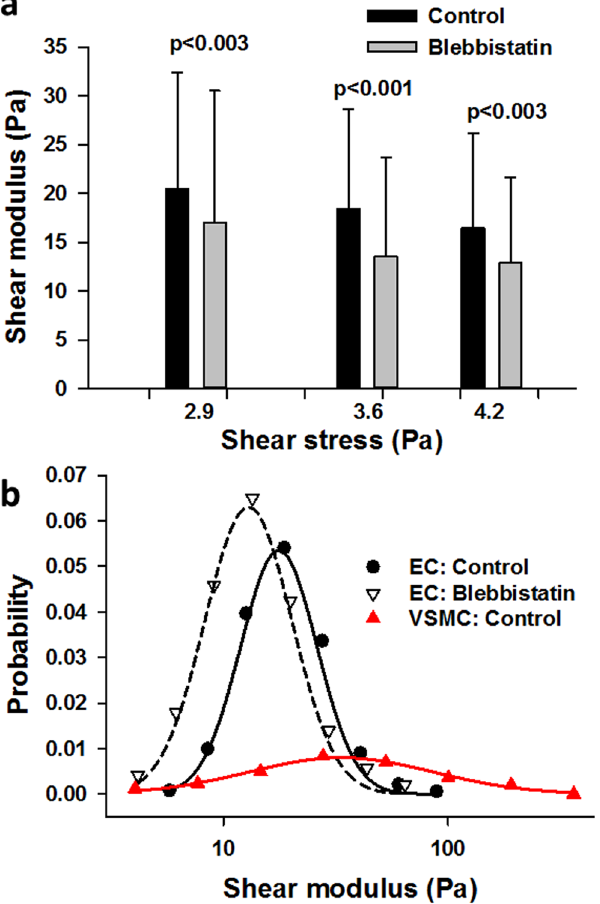
Figure 5. Shear moduli of endothelial and vascular smooth muscle cells. ( a ) The medians and interquartile ranges of shear moduli of > 200 endothelial cells exposed to 3 levels of shear stresses before and after blebbistatin treatment. There is a small but highly significant (p < 0.001, repeated measure ANOVA) decrease of the shear modulus with increasing shear stress. Also, there is a strong difference between the moduli before and after blebbistatin at all 3 shear stress levels (ranksum tests). ( b ) The distributions of shear moduli (lumped together for all 3 shear stresses for endothelial cells) are similar to a lognormal distribution both in control and blebbistatin-treated endothelial cells. The solid and dashed black lines are fits of the lognormal distribution with means (22.2 and 17.3 Pa) and variances (3.7 and 3.8 Pa 2 ) for the control and blebbistatin distributions, respectively. The read symbols correspond to the distribution of vascular smooth muscle cell (VSMC) moduli and the red solid line is the fit of the lognormal distribution with mean and variance of 89.3 Pa and 2.7 Pa 2 ,